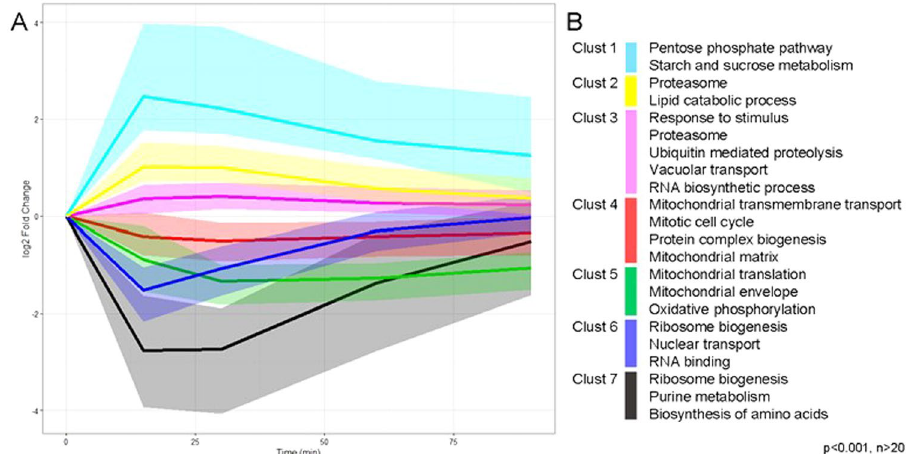
Figure 5. Hierarchical clustering of transcriptional changes in response to osmotic shock. ( A ) Seven clusters are presented, where the line represents the cluster median and the shaded area the distribution of the cluster. ( B ) Significantly enriched gene ontologies in each cluster. Gene ontologies with the pval < 0.001 and containing more than 20 significantly differentially expressed genes (adj. pval < 0.001) are